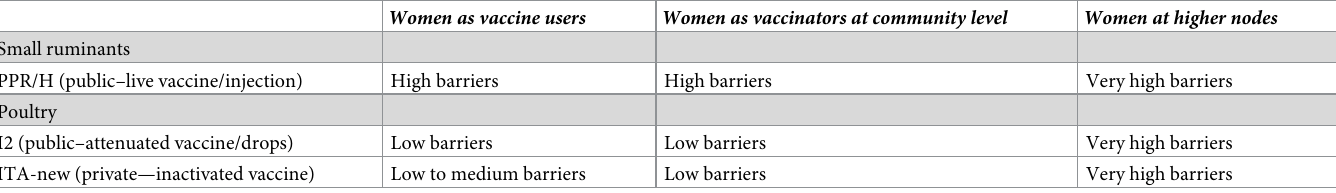
Table 2. Degree of barriers faced by women at different nodes of the VVC, by animal species and vaccine